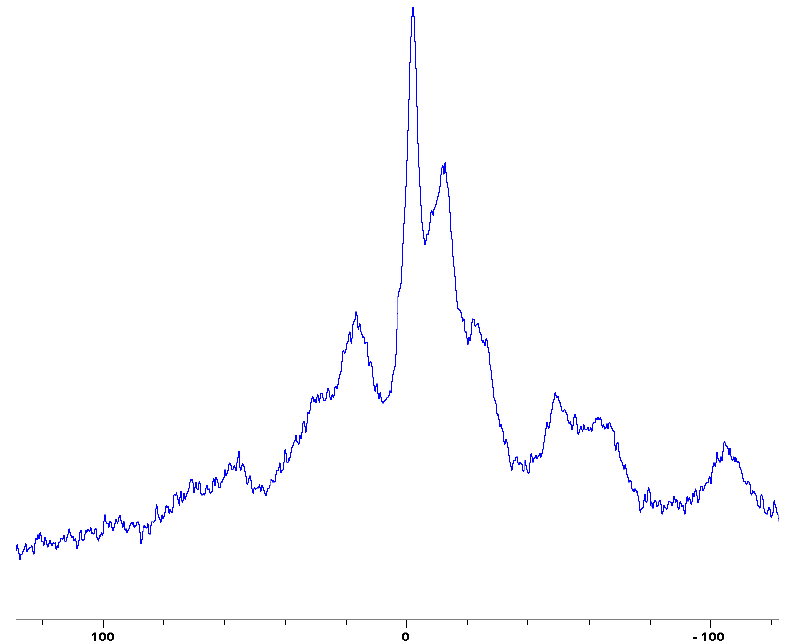
Figure 5. Solid-state 31 P-NMR spectrum of char obtained from fish gelatin + diethylphosphite (DEPi) (the abscissa denotes the chemical shift values, δ , in ppm and the ordinate corresponds to the signal intensity in arbitrary units).